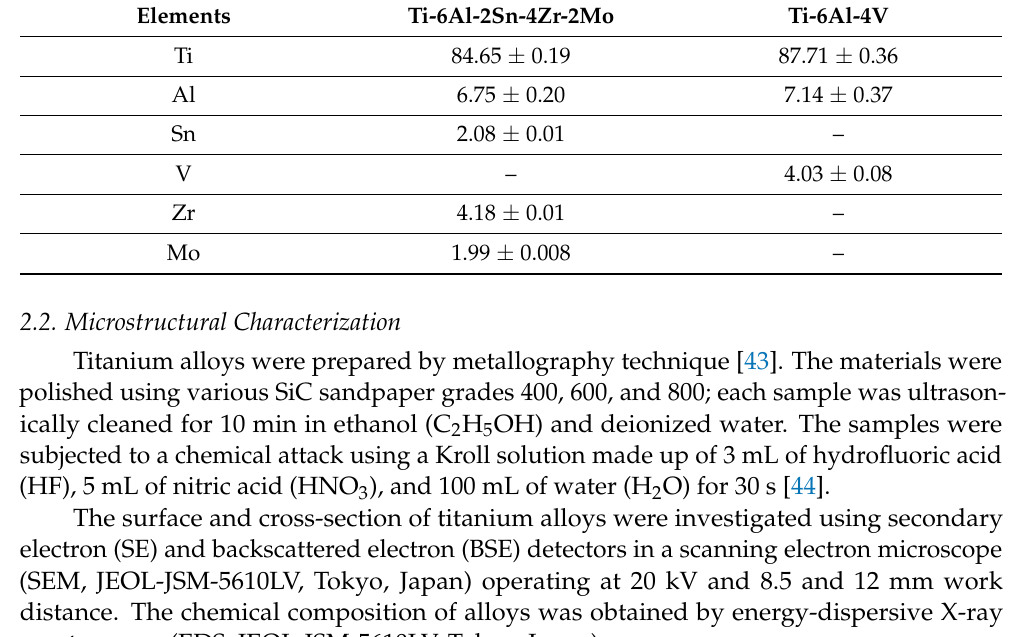
Table 1. Chemical composition of the titanium alloys (wt. %).